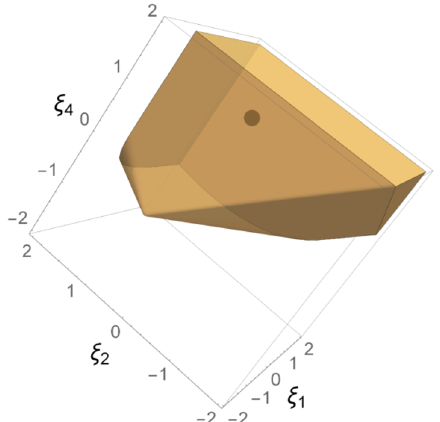
Figure 2 . Bounds on (4-Q) operators coefficients for N f = 3 . Plot showing in yellow the allowed region obtained for the (4-Q) (or, equivalently, (4-u)) operators with generic ξ values. Using the scaling invariance of the bounds and since ξ independent coefficients. The red dot indicates the natural MFV benchmark point, ξ that can be seen being inside the allowed